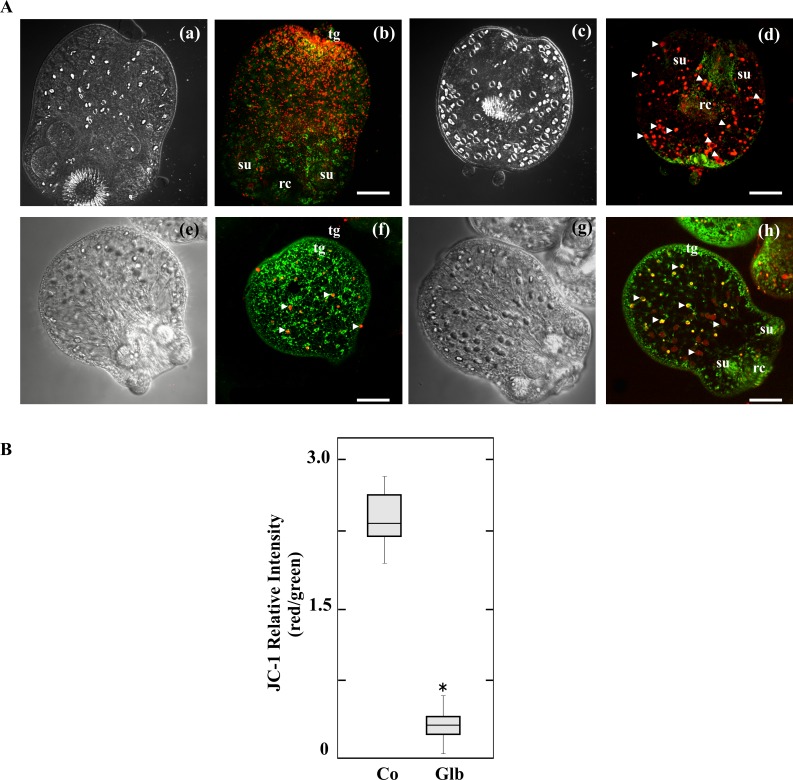
Mitochondrial membrane potential in glibenclamide treated-protoscoleces.(A) Representative confocal images showing JC-1 fluorescence in protoscoleces incubated under control conditions (a-d) or treated with 200 μM glibenclamide (Glb, e-h) for 24 h. tg: tegument; rc: rostellar cone; su: sucker. Bars indicate 50 μm. Red and yellow dots indicated by arrowheads correspond to stained calcareous corpuscles. (B) Boxplot graph showing the values of the red/green JC-1 fluorescence ratios measured in control (Co) and Glb-treated protoscoleces by Image J Software. *Statistically significant difference (p < 0.05) compared with control.